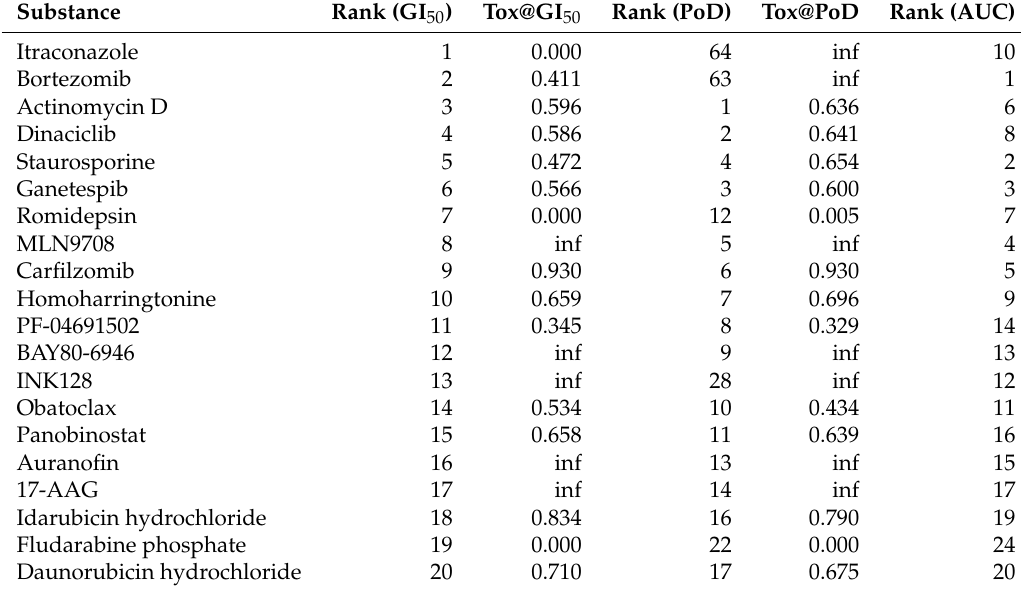
Table 1. Top 20 drugs and their toxicities, ranked by GI 50